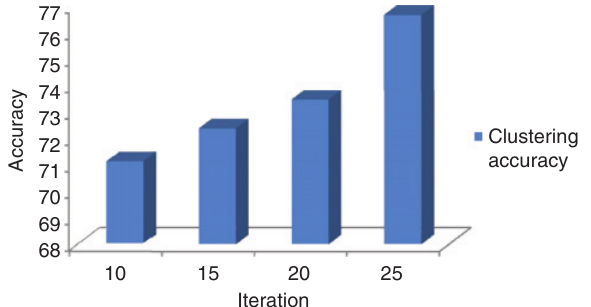
Figure 2: Graphical Representation of Clustering Accuracy for Our Proposed